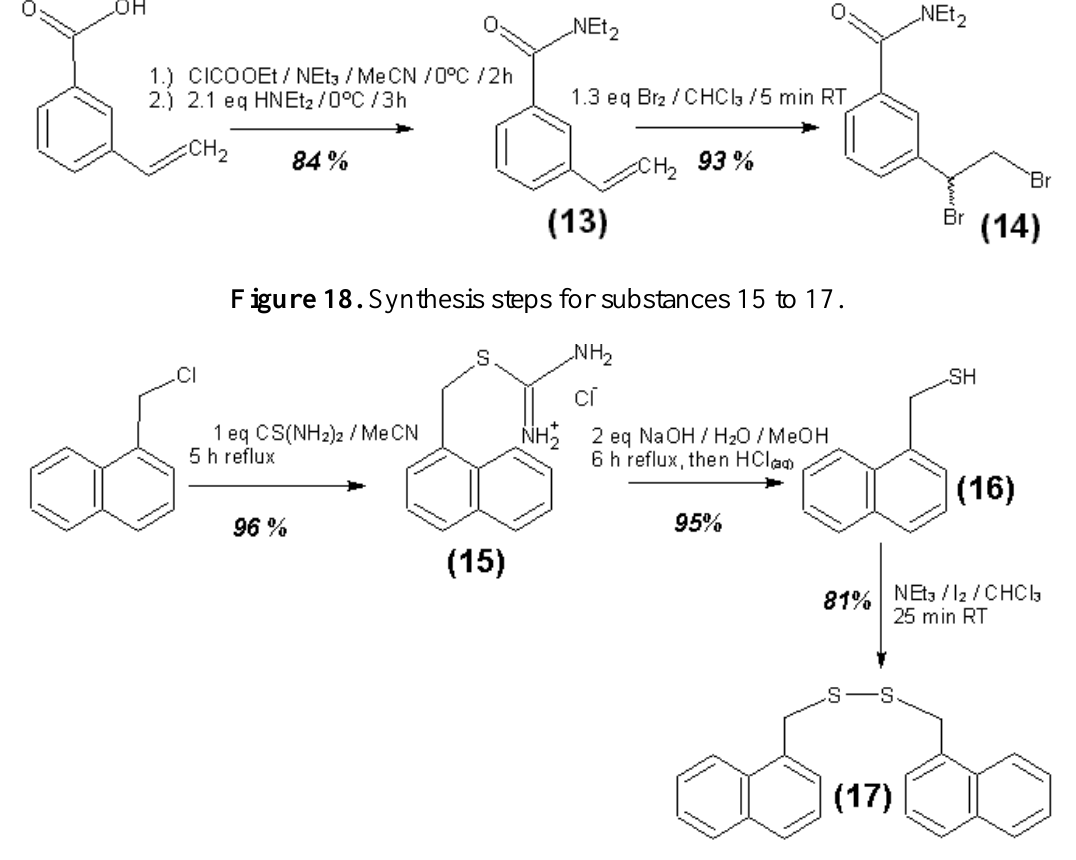
Table 5 compiles the measured extinction coefficients of the UV-active reagents ε at the λ wavelengths λ of the individual absorption maxima, their statistical concentration detection limits (at 98% confidence level), the absorption maxima of the reagents, and the solvents used. Table 5. Measured extinction coefficients ε , concentration detection limits, absorption λ maxima λ of the UV-active reagents and the solvent used for the reaction and